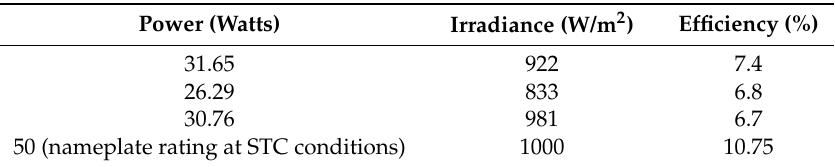
Table 6. Data for efficiency